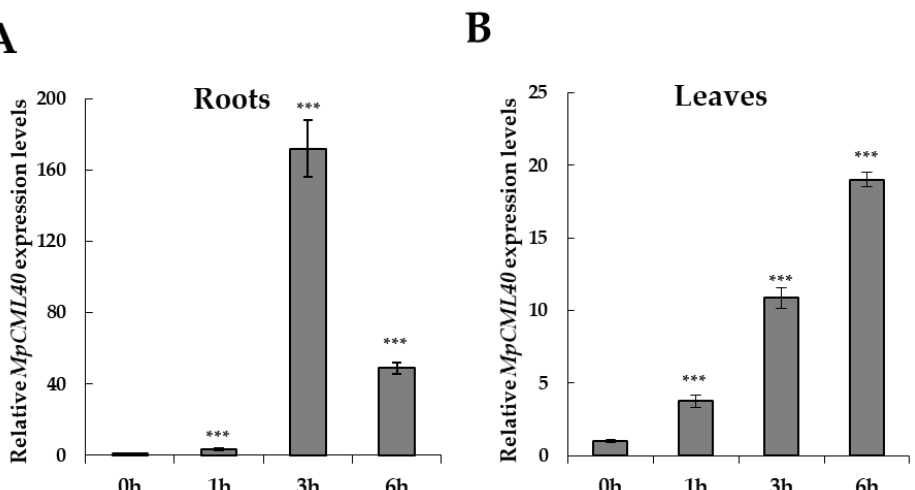
listed in Table 2. MpActin gene was used as an internal reference. Error bars show mean values (±SD) of three independent samples. *** p < 0.001 (Student’s t -test). Table 2. The list of primer sequences.